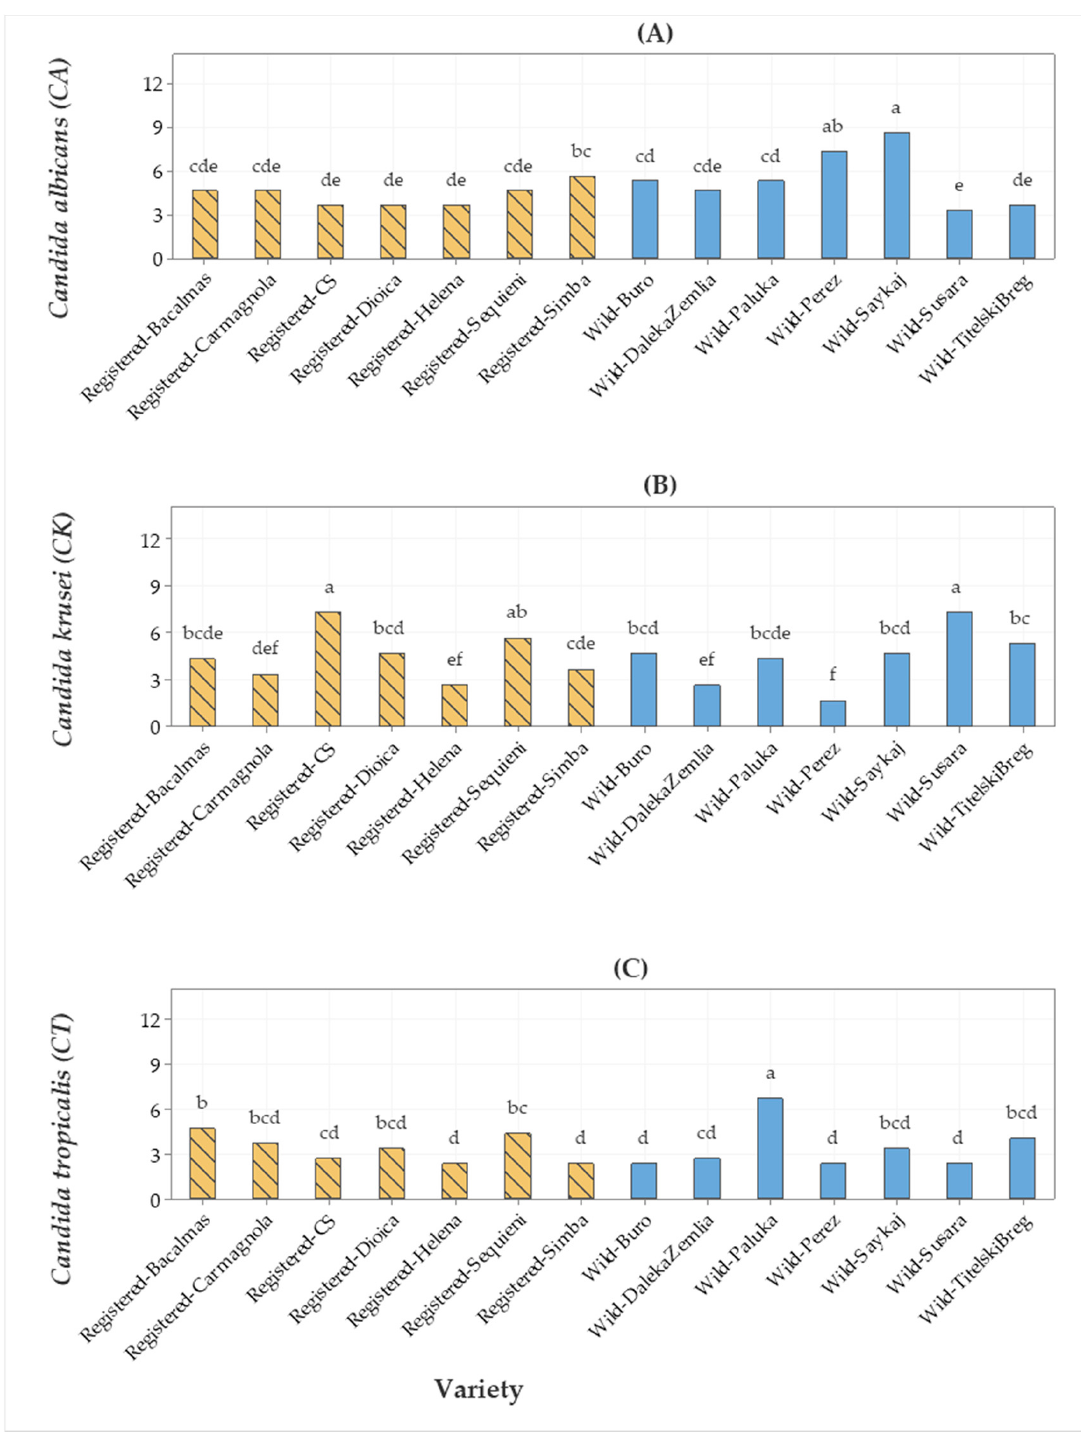
Figure 3 . Bar graph of ( A ) Candida albicans (CA), ( B ) Candida krusei (CK), and ( C ) Candida tropicalis (CT) (fluconazole) antimicrobial activities (inhibition zone in mm) from seven registered cultivars and seven wild hemp accessions. The means represented by the bars sharing the same letter are not significantly different.